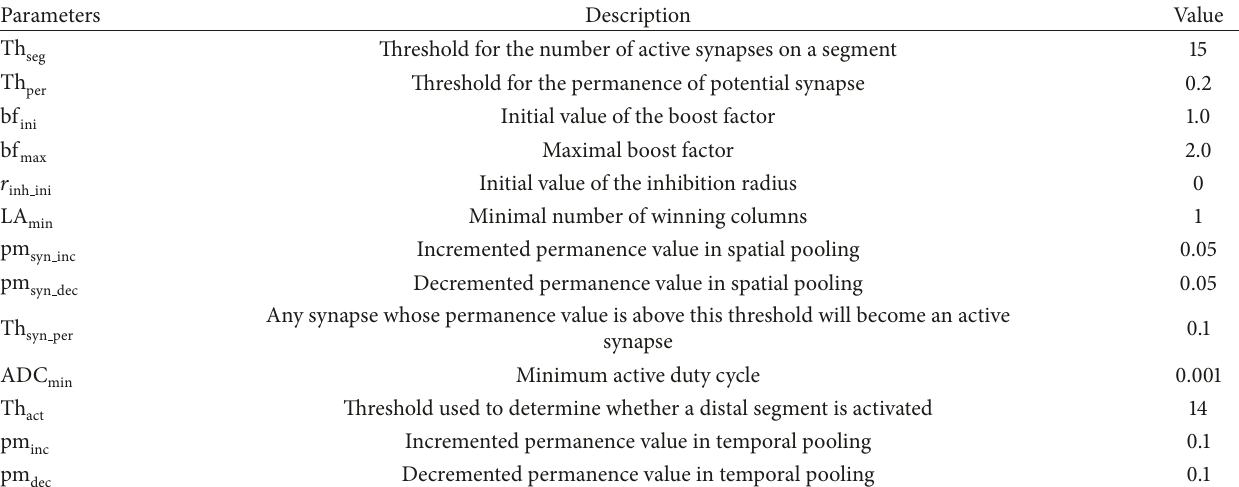
Table 2: Main optimal parameters for SP and TM algorithms.